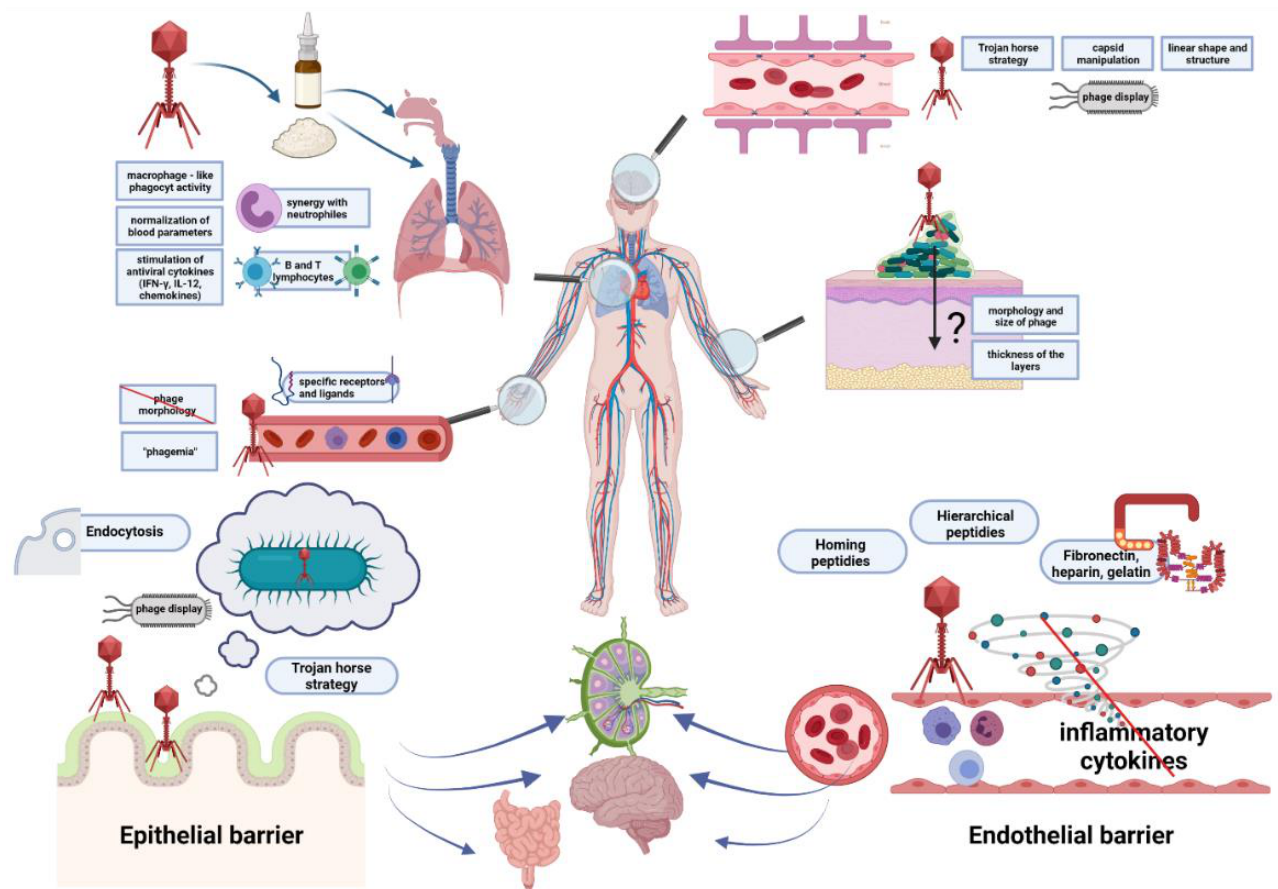
Figure 1. Barriers that must be crossed by bacteriophages to penetrate tissues and organs of animals and humans. Epithelial and endothelial barriers are shown in more detail in lower panels. Ways for penetration of bacteriophages to various tissues and organs are depicted and indicated by arrows. Specific strategies facilitating penetration, modifications of phages, and some effects of bacteriophages on animal and human organisms are presented in boxes. Bacteriophages, bacteria, and eukaryotic cells are shown as symbols mimicking their shapes, while proteins are marked as closed circles or other geometric figures.